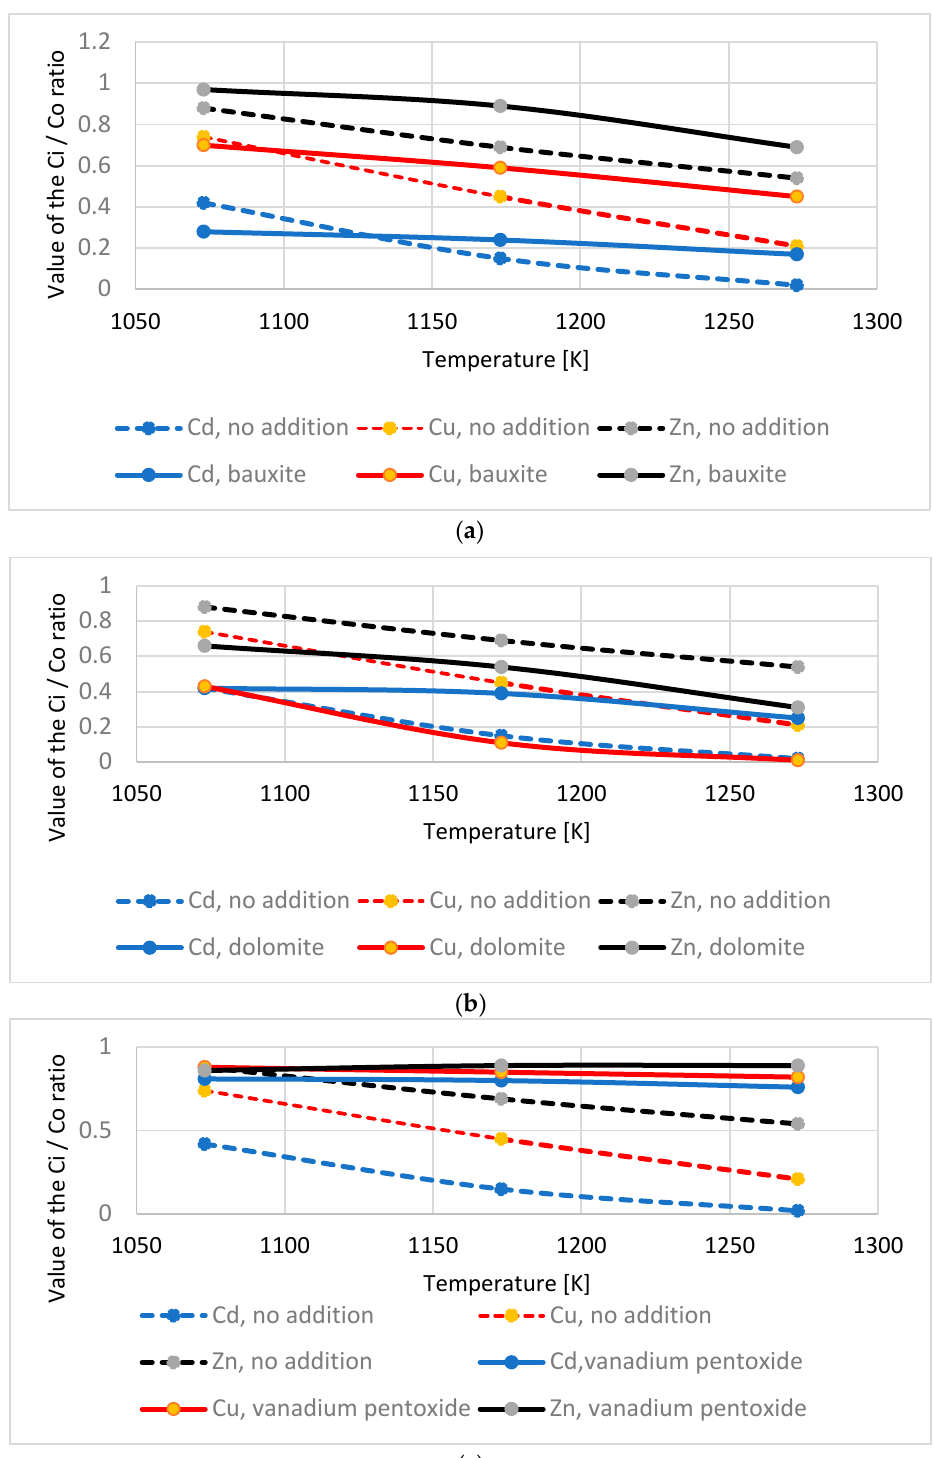
Figure 4. Dependence of Ci/Co value on roasting temperature in sulphate samples (VI); ( a ) with the addition of bauxite, ( b ) with the addition of dolomite, ( c ) with the addition of V 2 0 5.